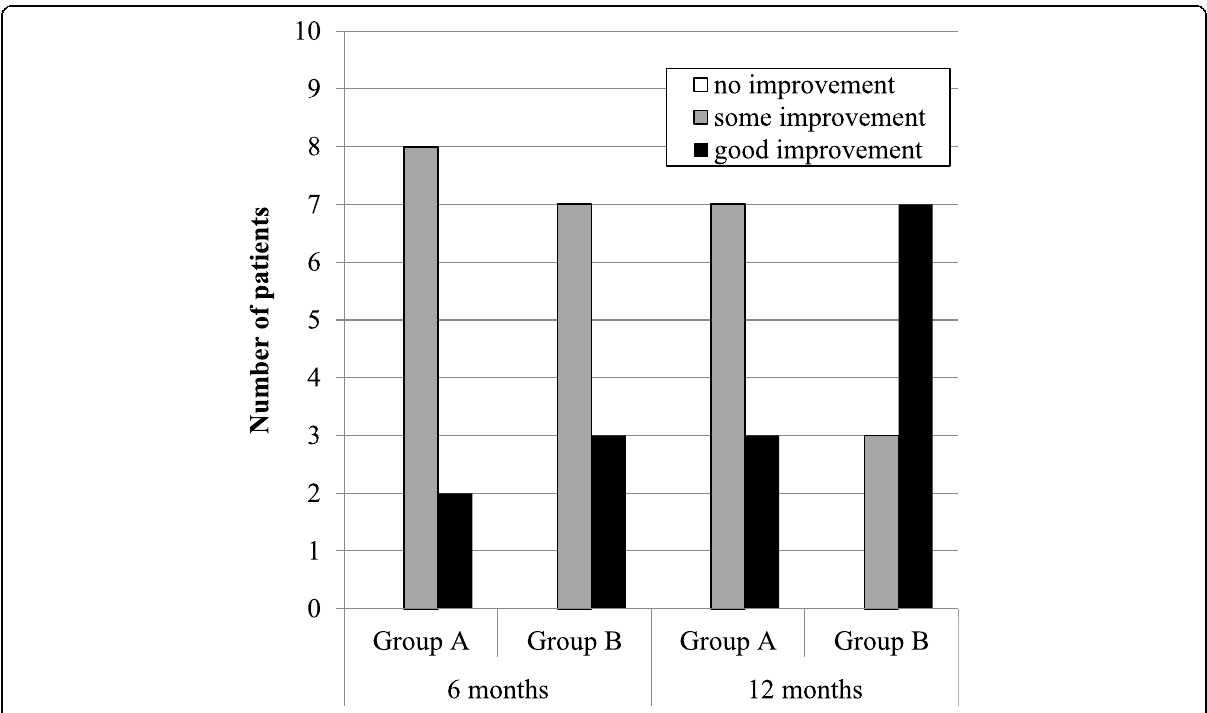
Fig. 3 Postsurgical outcomes classified by the criteria of